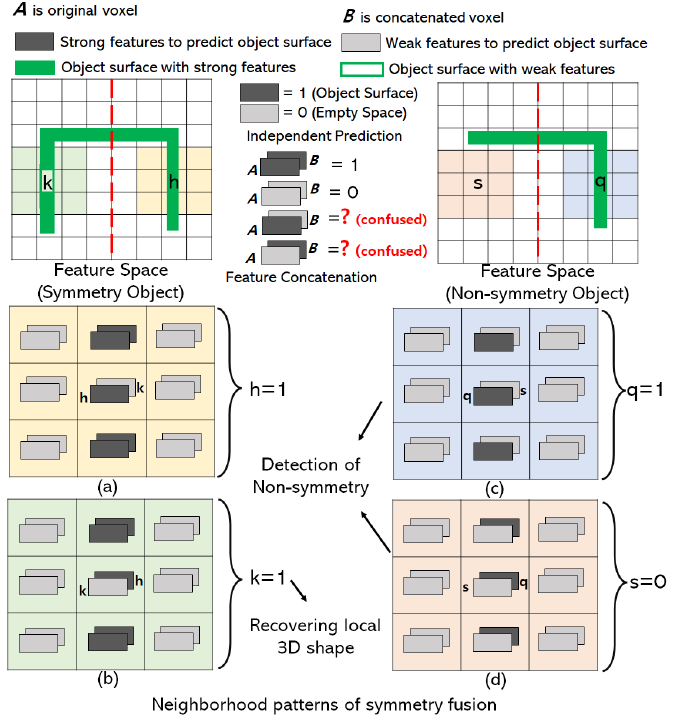
Figure 3. Symmetry fusion module recovers local shape and detects non-symmetry shapes. Network learns the neighborhood symmetry patterns for 3D reconstruction. The feature spaces of symmetry and non-symmetry object voxels in the symmetry fusion module are visualized as top view 2D grid for simplicity. The red dotted line is a symmetry plane in 2D. The solid green line represents the object surface with strong features. ( a ) Prediction of object voxel with weak features in symmetry structure. ( b ) Recovering object voxel with weak features. ( c , d ) Detection of Non-symmetry